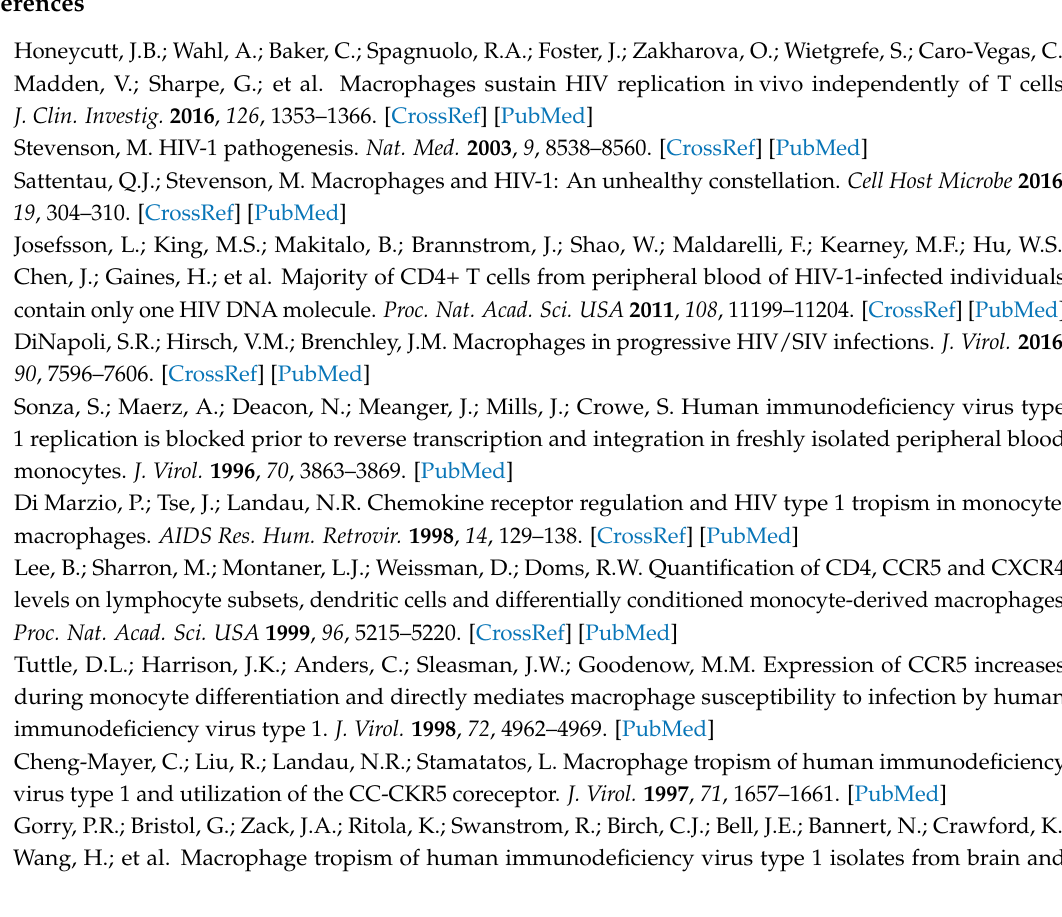
Table S1: RNAseq showing differential expression of microRNAs in monocytes and macrophages. The expression profile of 1394 microRNAs obtained by RNAseq of monocytes and their corresponding derived macrophages ( n = 2 blood donors) are shown. The base mean is the average expression of the microRNA in both monocytes and macrophages (combined). The log2 fold change corresponds to the log2[macrophage mean/monocyte mean], thus a positive log2 fold change corresponds to an up regulation in macrophages and a negative log2 fold change to that of a down regulation in macrophages following monocyte differentiation. Standard deviation of the log2 fold change is in column E. The statistical probability ( p value) is derived from the log2 fold change and microRNAs are listed in order of log2 fold